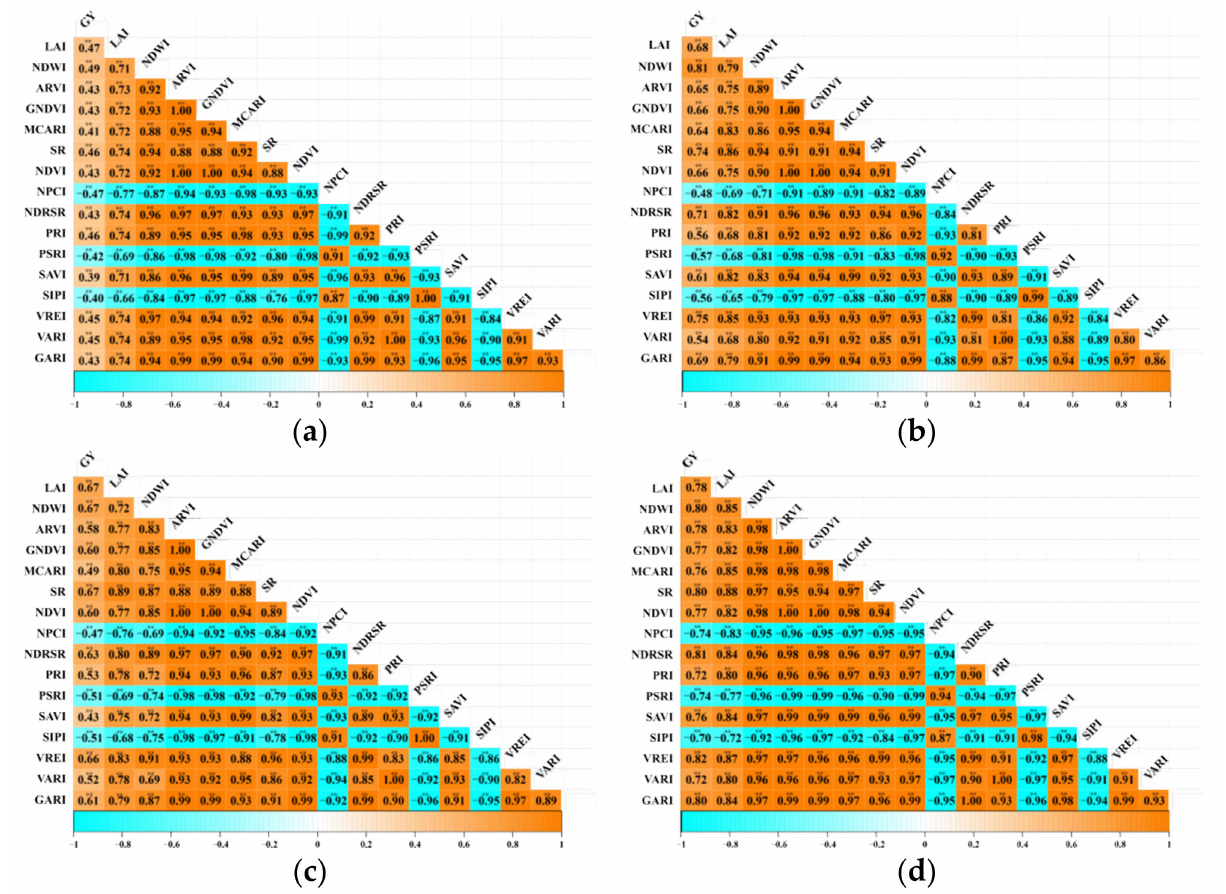
Figure A2. The correlation matrices between each index and grain yield. ( a ) Jointing stage; ( b ) Flagging stage; ( c ) Anthesis stage; ( d ) Grain filling stage. Significant (**) at p < 0.01.